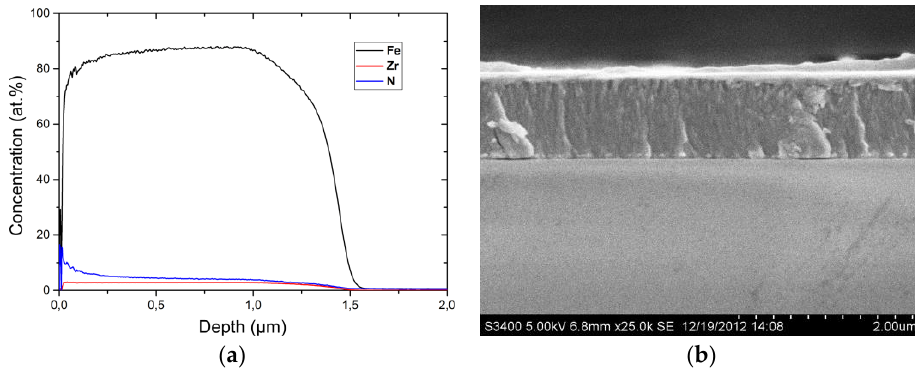
Figure 2. ( a ) Distribution of elements (GDOES) and ( b ) micrograph (SEM) of the cross section of the Fe 92.2 Zr 3.0 N 4.8 film.